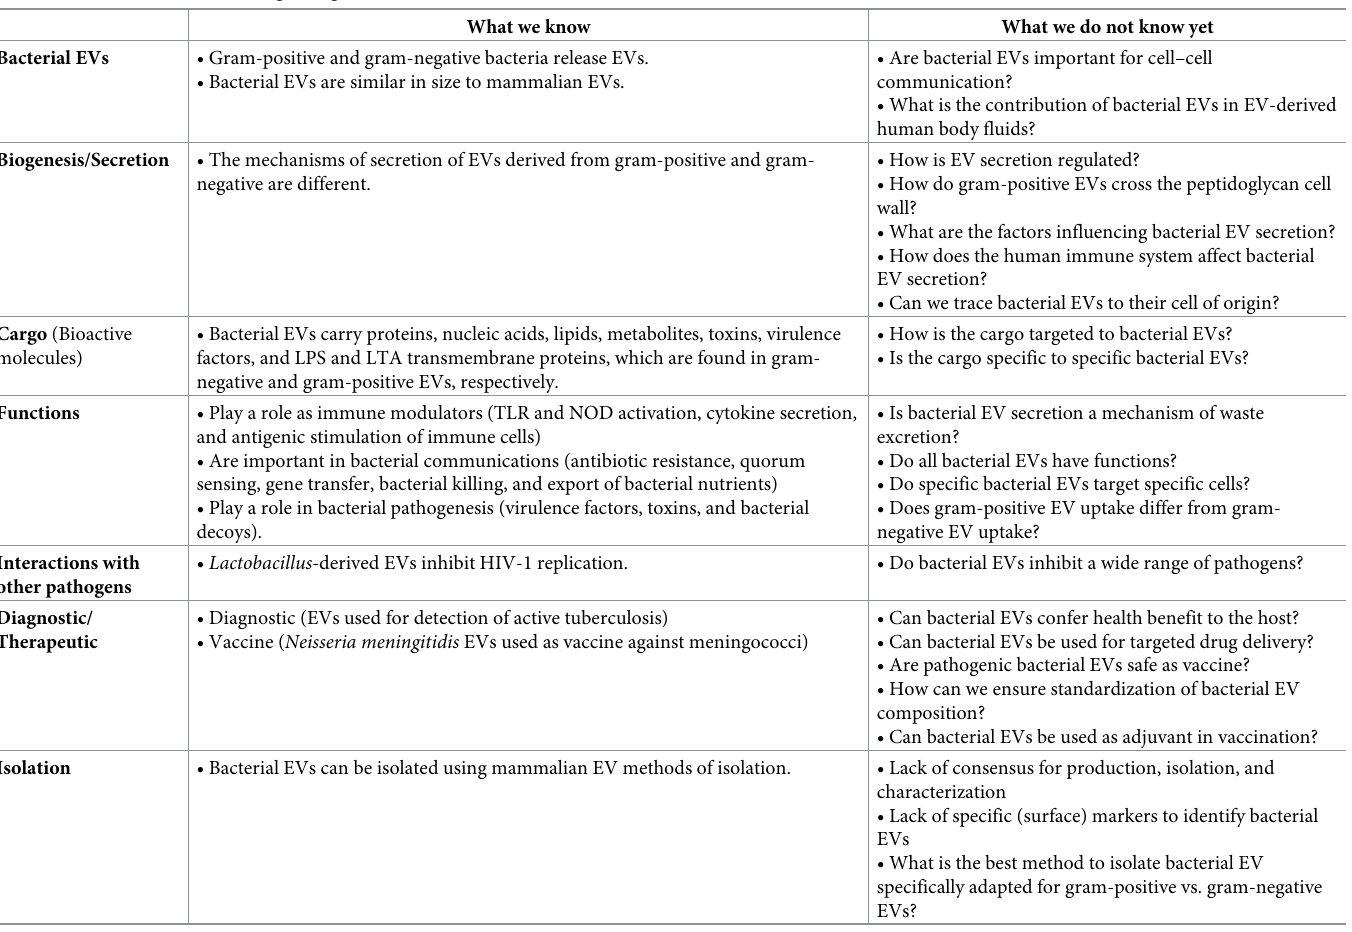
Table 3. What we have to learn regarding bacterial